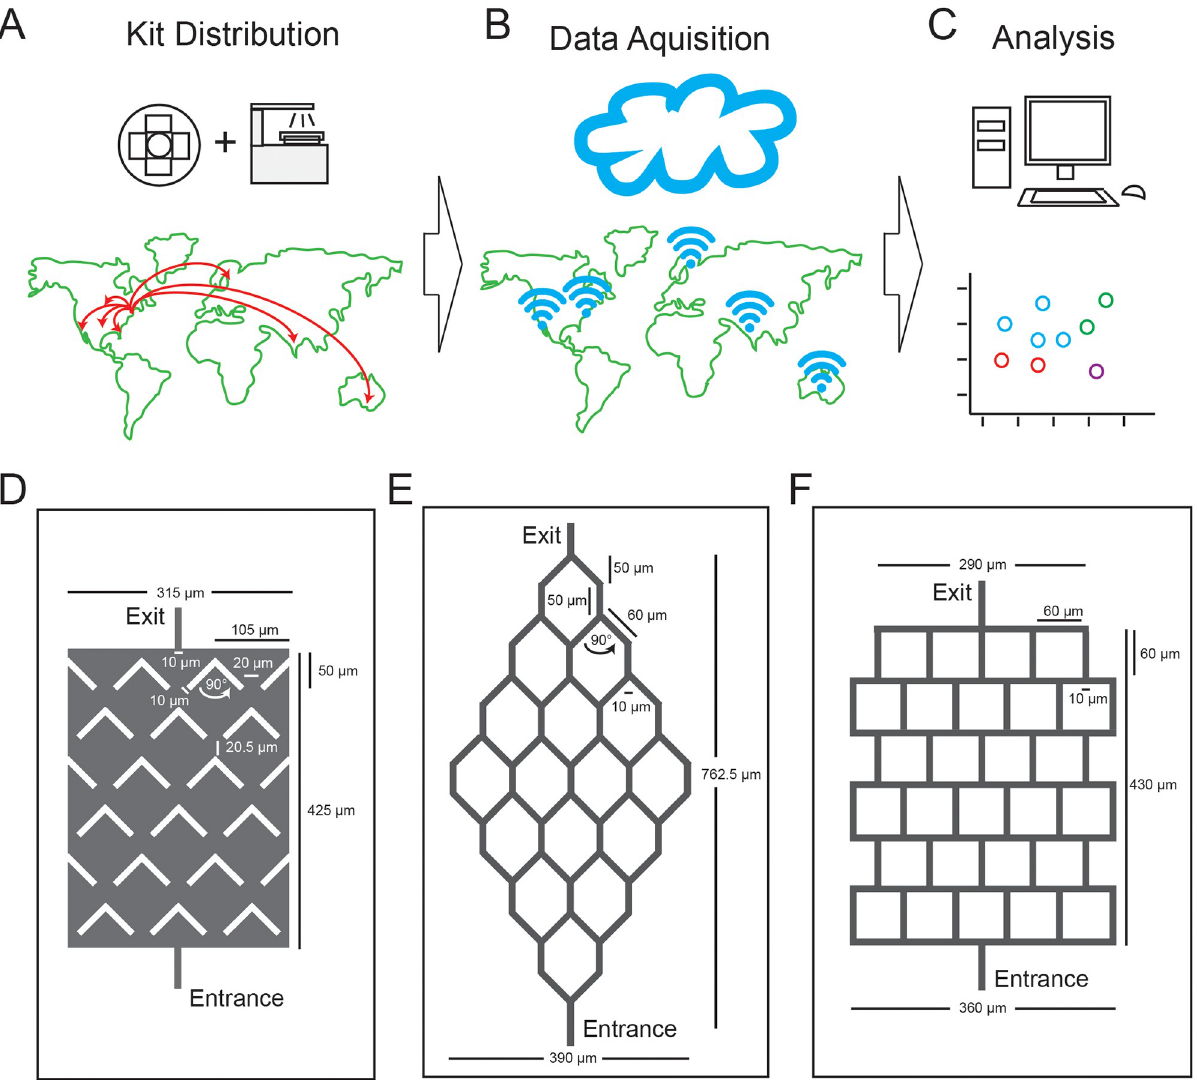
Fig 1. The Fungus Olympics, an international collaborative study of fungal hyphae in microfluidic mazes. A-C) Overview of approach: (A) Microfluidic devices and CytoSmart mini microscopes are distributed to participating research groups around the world; (B) Each group performs experiments and uploads results to an online server; (C) Data is analyzed and hyphal growth patterns compared. D-F) Microfluidic mazes for analyzing hyphal growth: (D) "Boomerang" maze contains a challenging array of angular obstacles designed to trap hyphae growing from the entrance at the bottom; (E) "Honeycomb" maze presents hyphae with hexagonal challenges requiring turns of 45˚; (F) "Square" maze presents hyphae with a series of 90˚ surfaces. Open growth channels are shown in gray. Three maze designs and straight channels for measuring hyphal velocity were present in each microfluidic